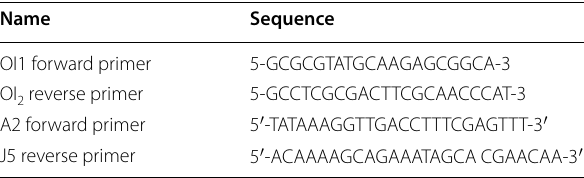
Table 1 Description of specific primers used for